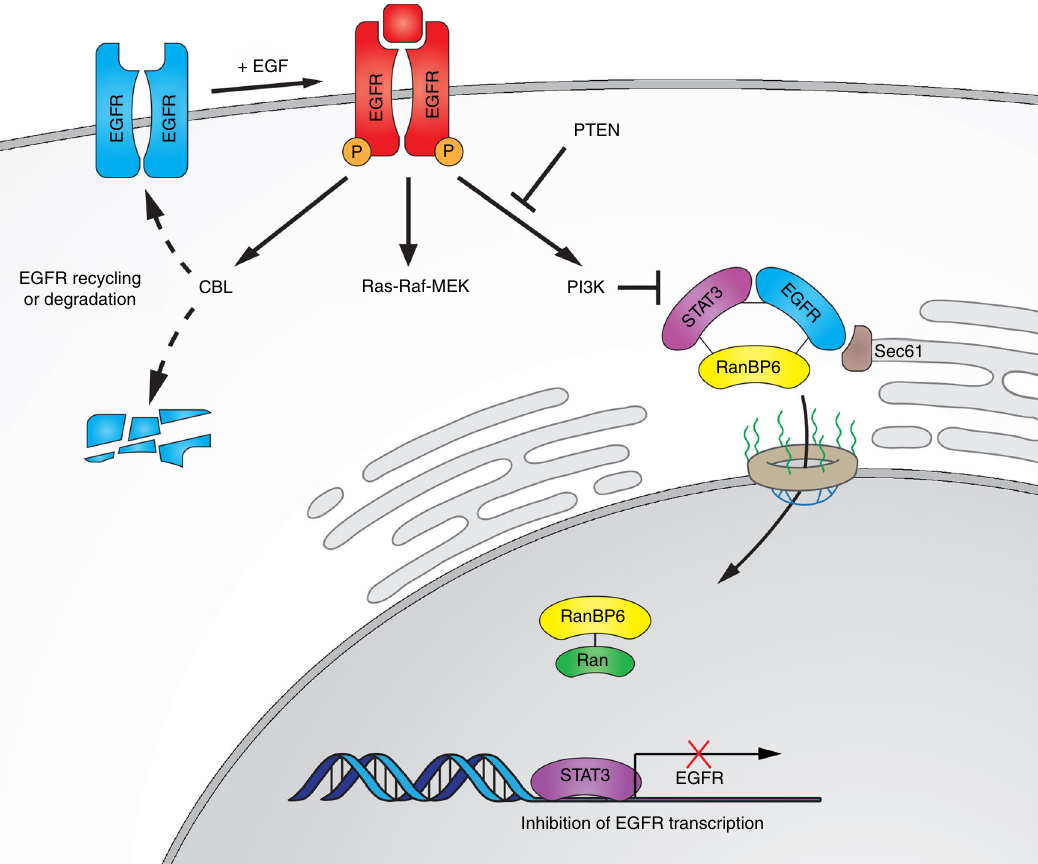
Fig. 7 EGFR regulation by RanBP6 (model). A (small) pool of EGF receptors functions as a scaffold for RanBP6-mediated nuclear import of STAT3. Nuclear STAT3 represses EGFR transcription. The solid lines between EGFR – STAT3 – RanBP6 and RanBP6 – Ran indicate protein – protein interactions (i.e., not necessarily direct molecular interactions). This mechanism of EGFR regulation serves to repress EGFR transcription at steady state and is inactivated when the cellular demand for EGFR transcription increases (e.g., following EGF-induced receptor protein degradation). Cancer cells inactivate this